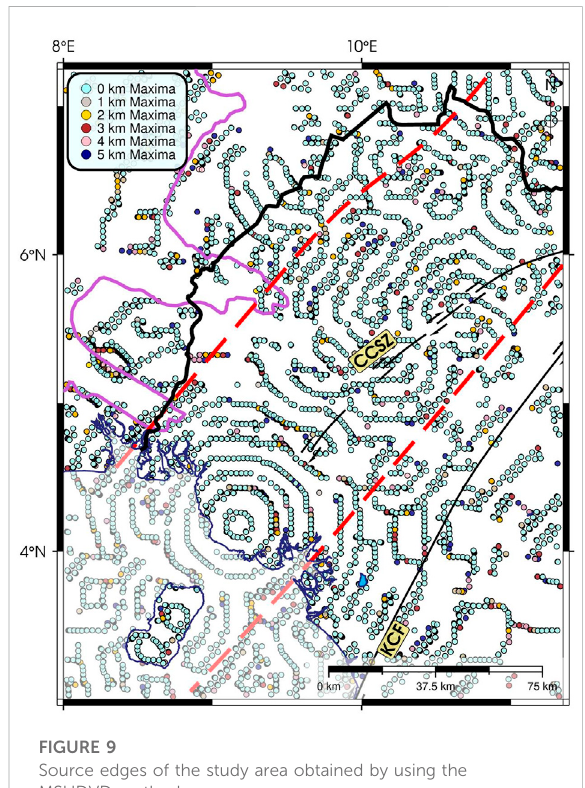
FIGURE 9 Source edges of the study area obtained by using the MSHDVD method.